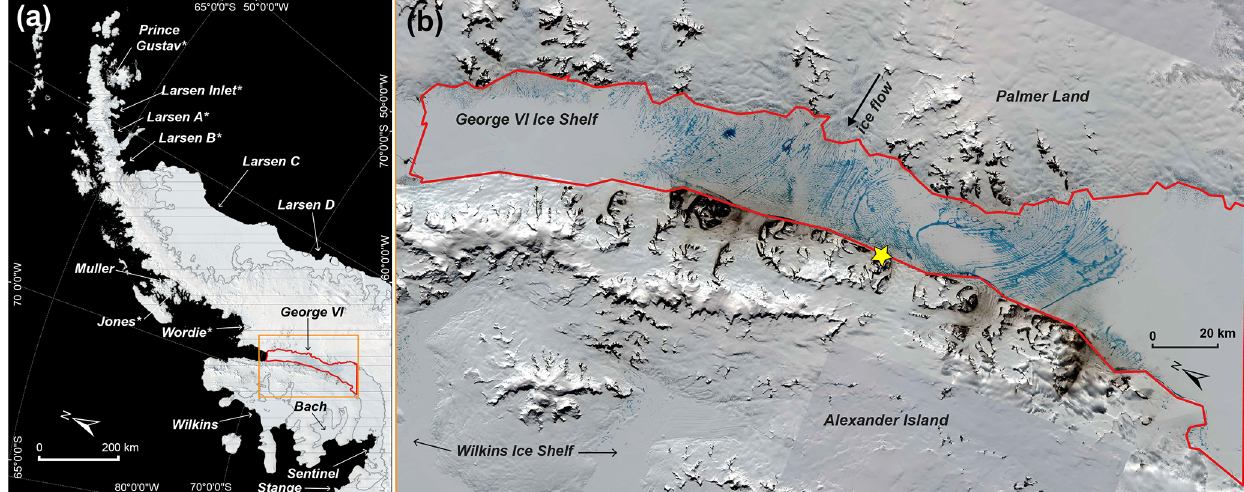
Figure 1. (a) Mosaic of cloud-free Moderate Resolution Imaging Spectroradiometer (MODIS) images over the AP from 19 January to 7 February 2020. The MODIS mosaic is sea ice masked and the ice shelves are delineated with grey lines using the U.S. National Ice Center Operational Antarctic Ice Front and Coastline Data Set 2017–2020 (Readinger, 2021). Ice shelves are labelled with white text; those with ∗ have lost > 50% of their original area since the 1950s (Cook and Vaughan, 2010). The red outline shows the study’s area of interest (AOI) over the northern GVIIS. The orange box depicts the area shown in (b) . (b) A mosaic of optical images over the northern GVIIS AOI. All images are Sentinel-2 tiles dated 19 January 2020, apart from the two darker tiles (top right and lower right, outside of the AOI), which are Landsat 8 image tiles from 17 and 19 January 2020. The study AOI is delineated by the red outline, and the yellow star shows the location of the Fossil Bluff